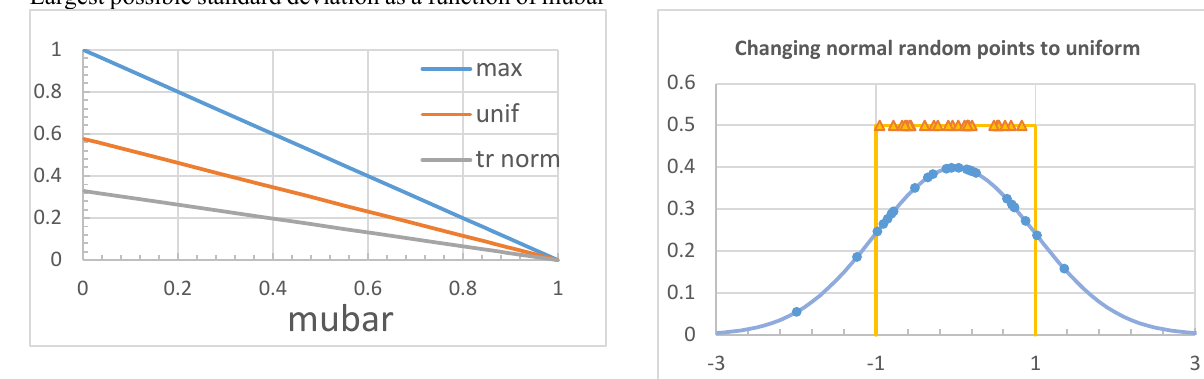
where b = the right hand limit. a = the left hand limit.